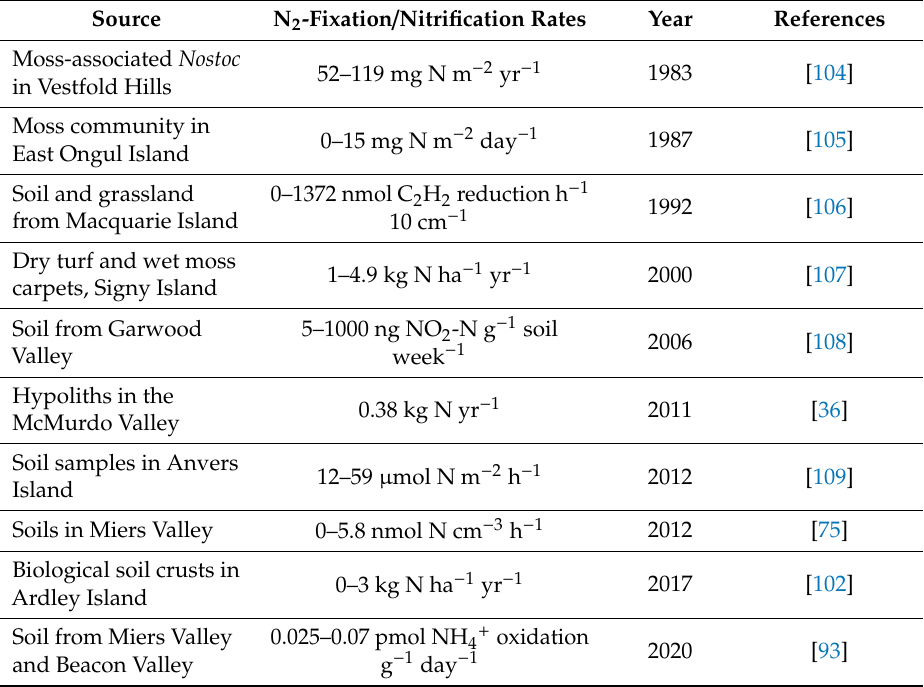
Table 3. Quantification of N 2 -fixation and nitrification processes in terrestrial Antarctic soil